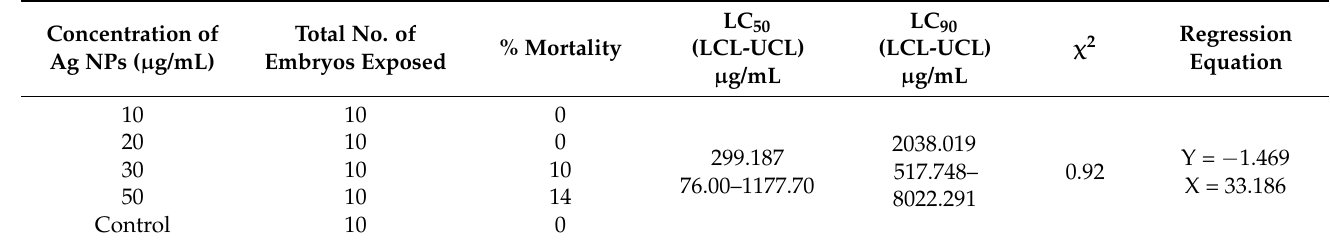
Table 6. Toxicity assay of Priestia aryabhattai -mediated Ag NPs on Artemia nauplii . Table 7. Toxicity assay of Pantoea stewartii -mediated Ag NPs on embryos.